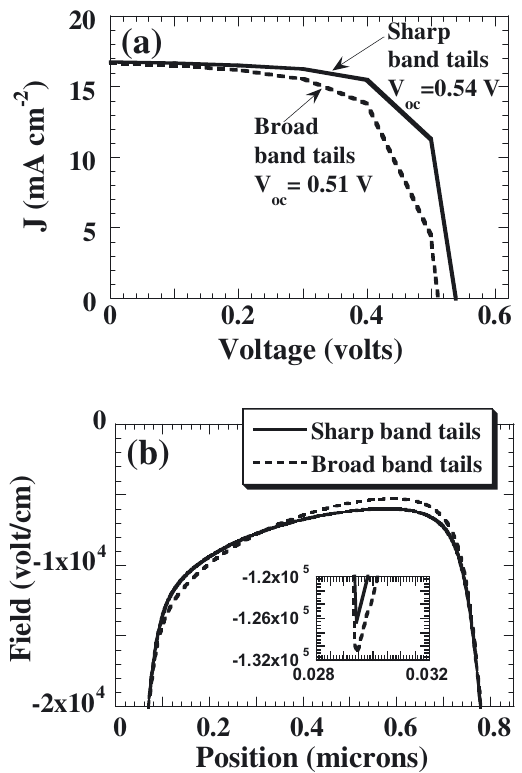
Fig. 6. (a) Sensitivity of the illuminated J - V characteristic to the valence and conduction band tail characteristic energies and (b) the electric field in the device when the band tails are sharp (characteristics energies of band tails E D , E A = 20 meV, 10 meV respectively, characteristic of μ c-Si:H cell type (A) and when they are broader ( E D , E A = 40 meV, 20 meV respec- tively, characteristic of cell type (B). The electric field over the P/I interface region is plotted on a different scale in the